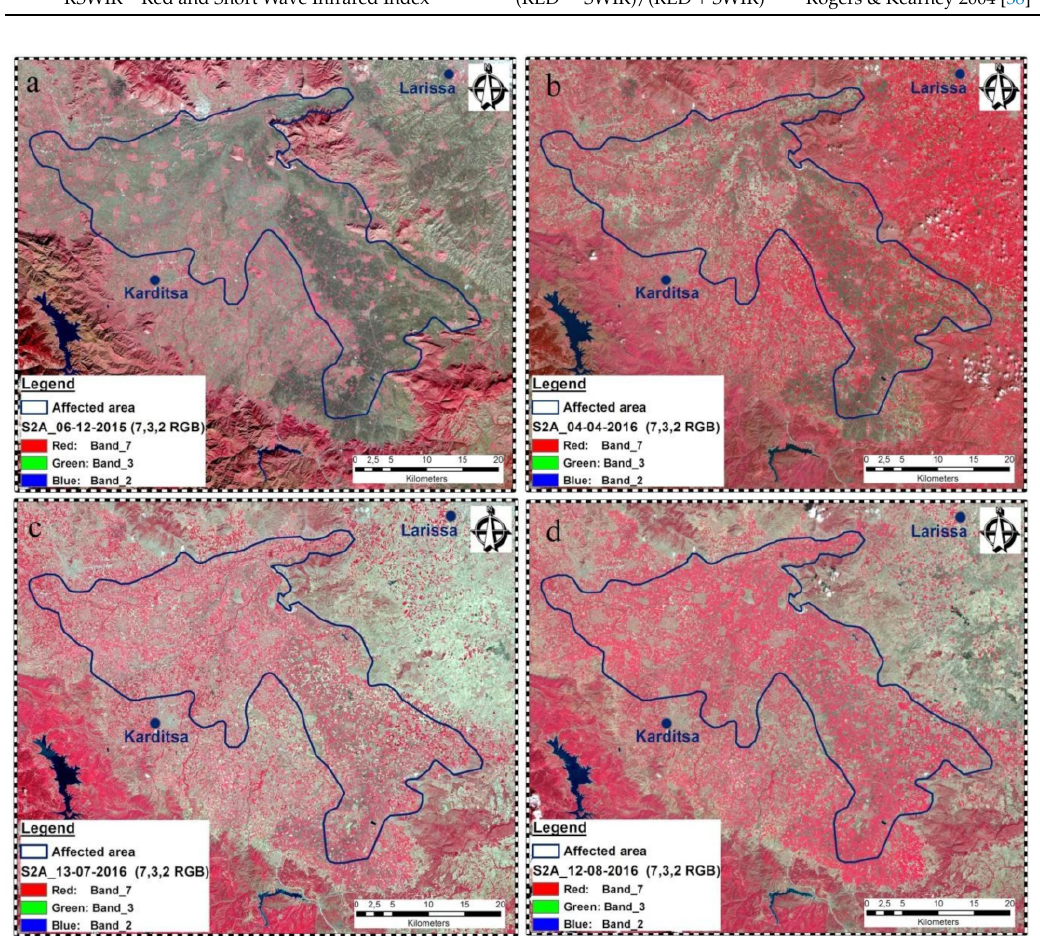
Figure 4. The four S2 images (False Color Composite: NIR, red, green band as RGB) used for the classification of the land use/cover of the area ( a ) 6 December 2015, ( b ) 04 April 2016, ( c ) 13 July 2016, and ( d ) 12 August